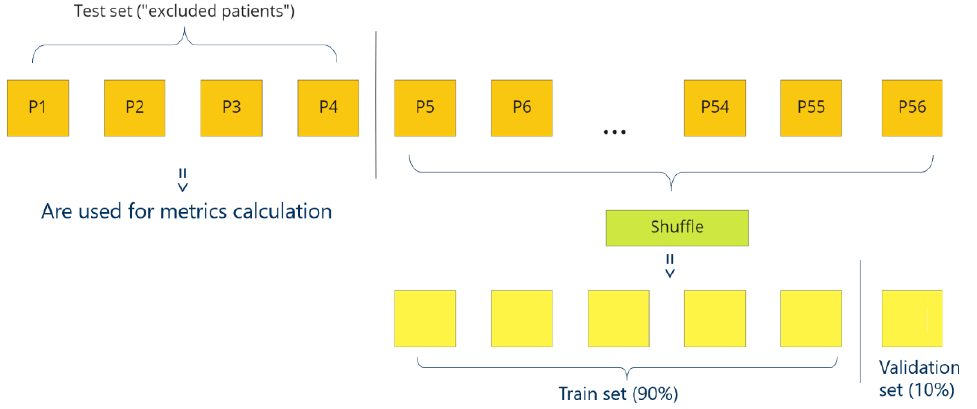
Figure 9. How cross-validation works. P1–P56—patients.